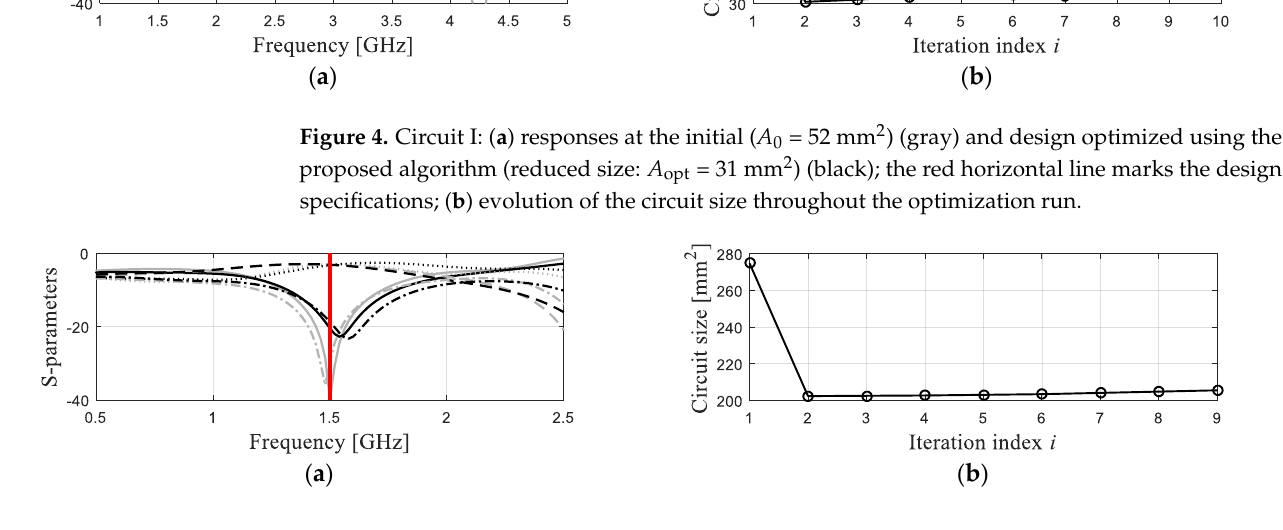
Figure 5. Circuit II: ( a ) responses at the initial ( A 0 = 275 mm 2 ) and design optimized using the proposed algorithm (reduced size: A opt = 205 mm 2 ), indicated using gray and black, respectively; S -parameters marked as | S 11 | (—), | S 21 | ( ···· ), | S 31 | (- - -), | S 41 | (- .); the vertical line marks the circuit operating frequency; ( b ) evolution of the circuit size throughout the optimization run.